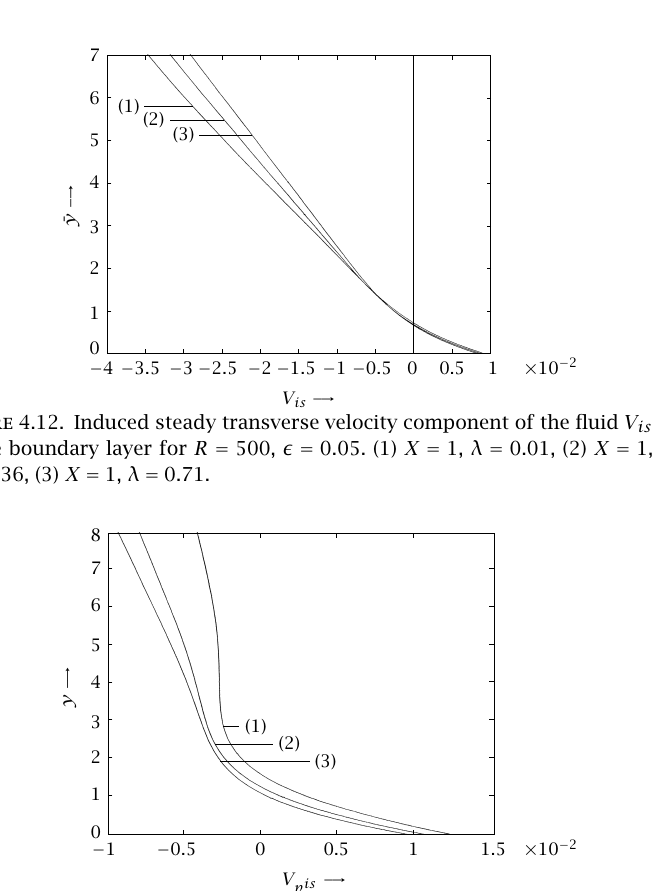
Figure 4.11 . Transverse velocity component of the particle V boundary layer for R = 500, 4 = 0 . 05, t = 2. (1) X = − 1, λ = 0 . 01, (2) X = − 1, λ = 0 . 36, (3) X = − 1, λ = 0 . 71.